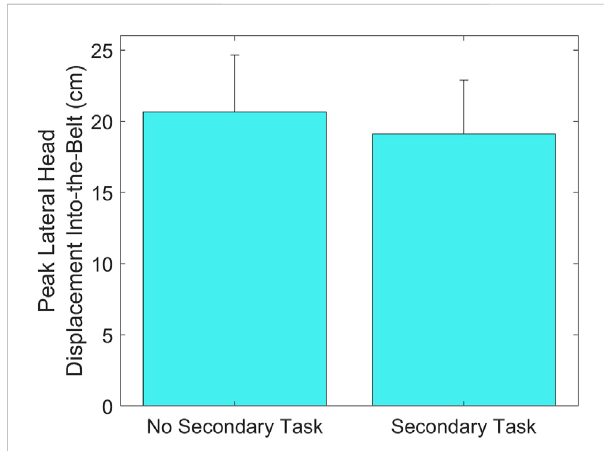
Groupmeans±SDforPeakLateralHeadDisplacementInto-the- Belt without and with the Secondary